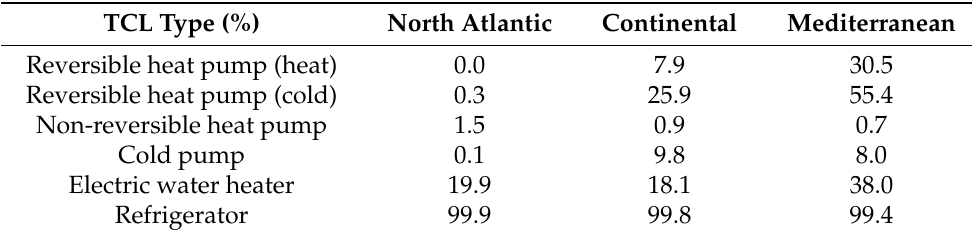
Table 1. TCLs penetration (%) in Spain in 2010 according to [13].